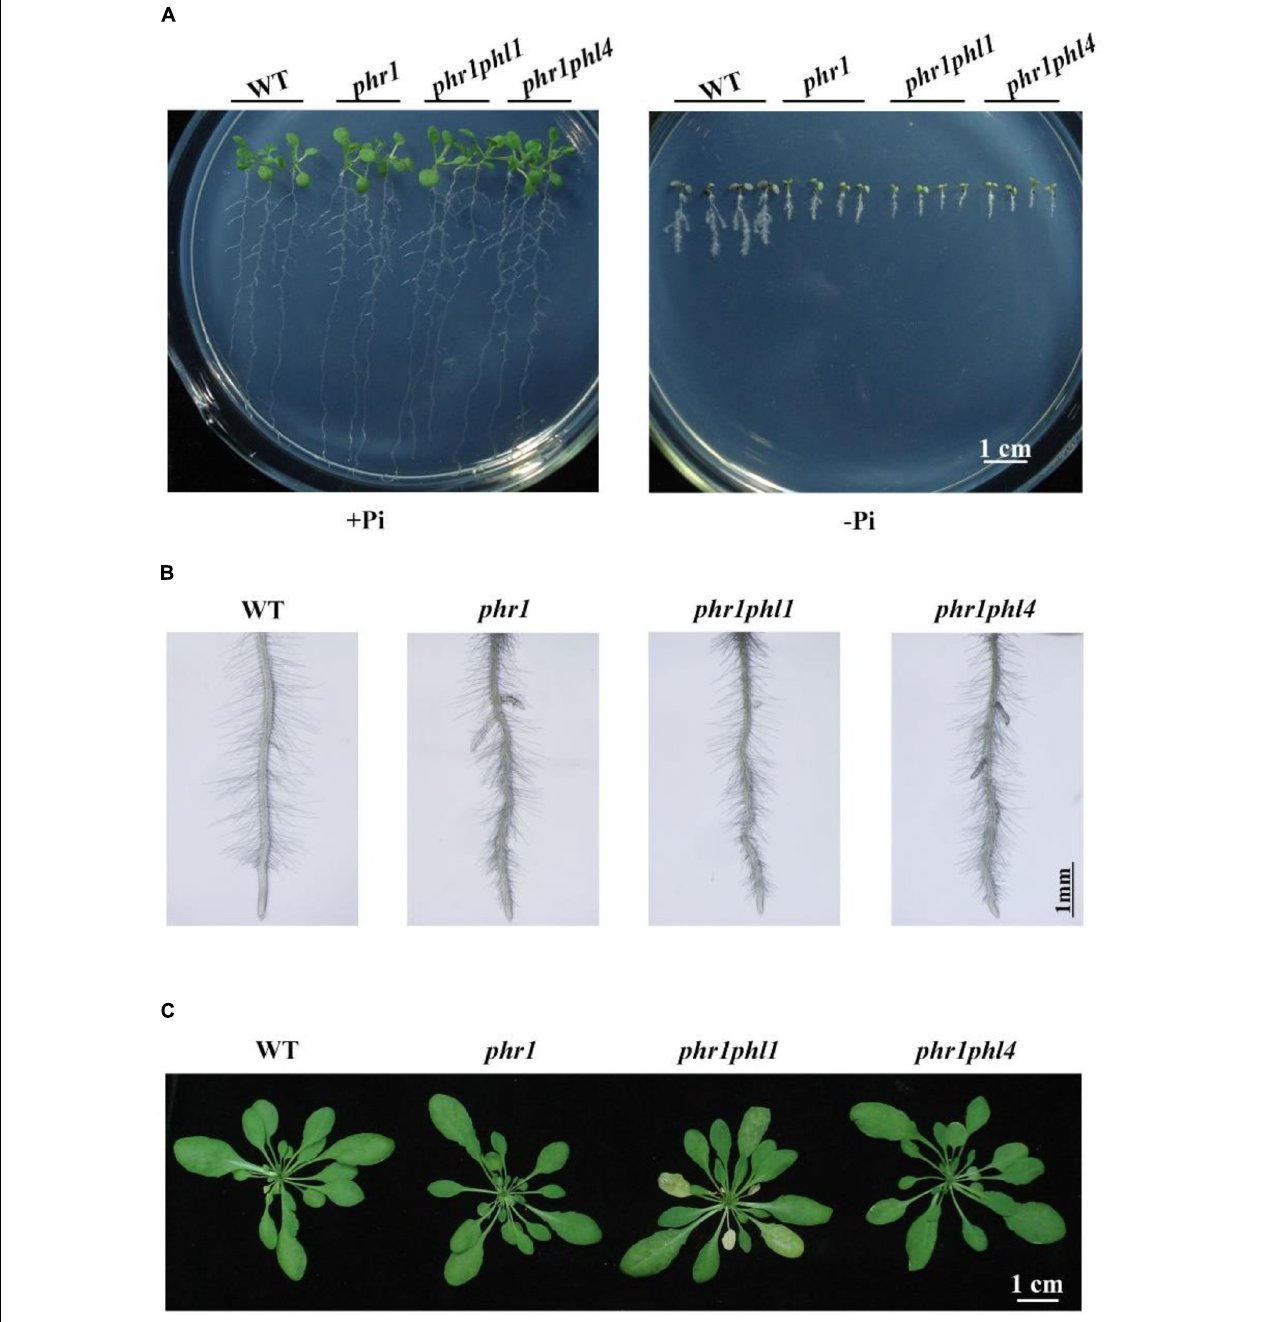
FIGURE 6 | Phenotypic analysis of phr1phl1 and phr1phl4 double mutants. (A) Morphology of 10-day-old seedlings of the WT, phr1 , phr1phl1 , and phr1phl4 grown on +Pi and –Pi media. (B) Root hairs of 6-day-old seedlings of WT, phr1 , phr1phl1 , and phr1phl4 grown on –Pi medium. (C) Morphology of 5-week-old plants of the WT, phr1 , phr1phl1 , and phr1phl4 grown in soil. The flower stalks were removed.